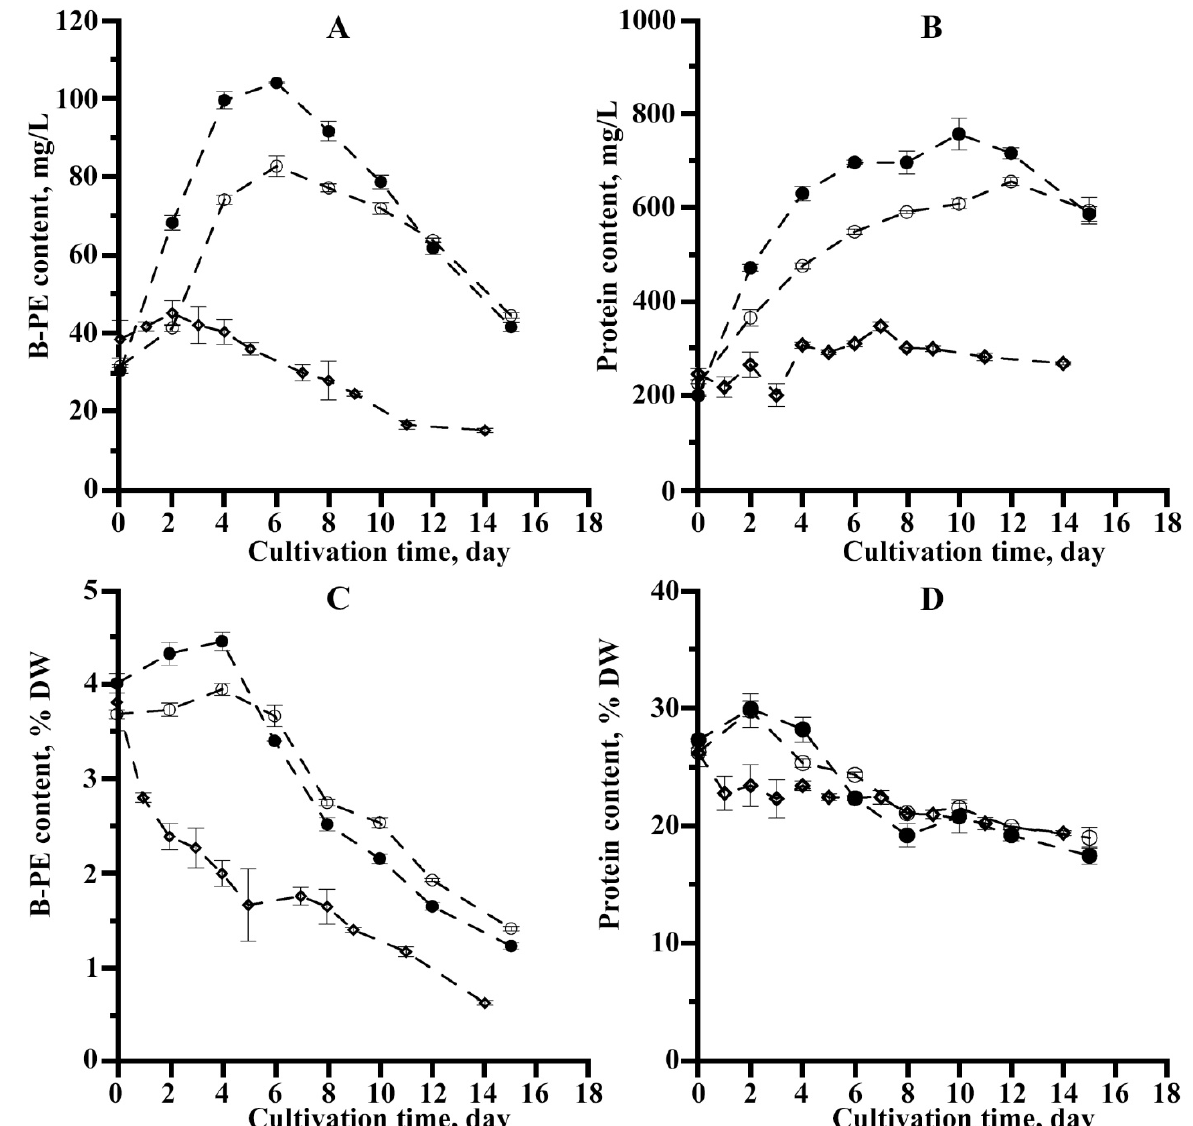
Figure 3. B-PE ( A ) and protein ( B ) content in P . purpureum culture and its biomass ( C , D, respec-